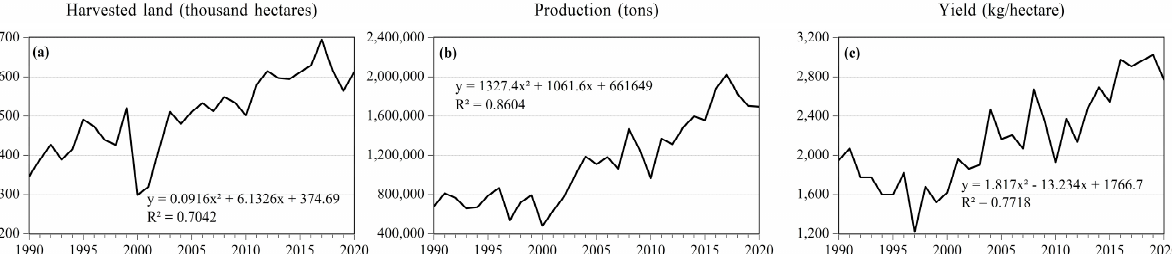
5 of 19 parametric tests; MK is used to indicate trends (i.e., increase or decrease) in the studied time series, whereas the Sen slope computes the value of the change (slope).